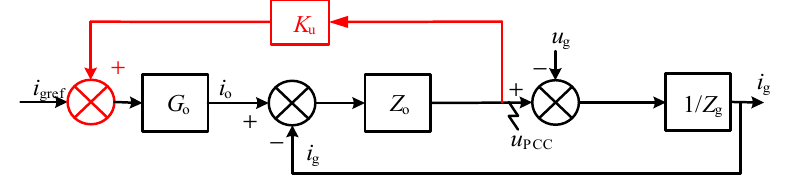
Figure 5. The structure of grid voltage feedback control.